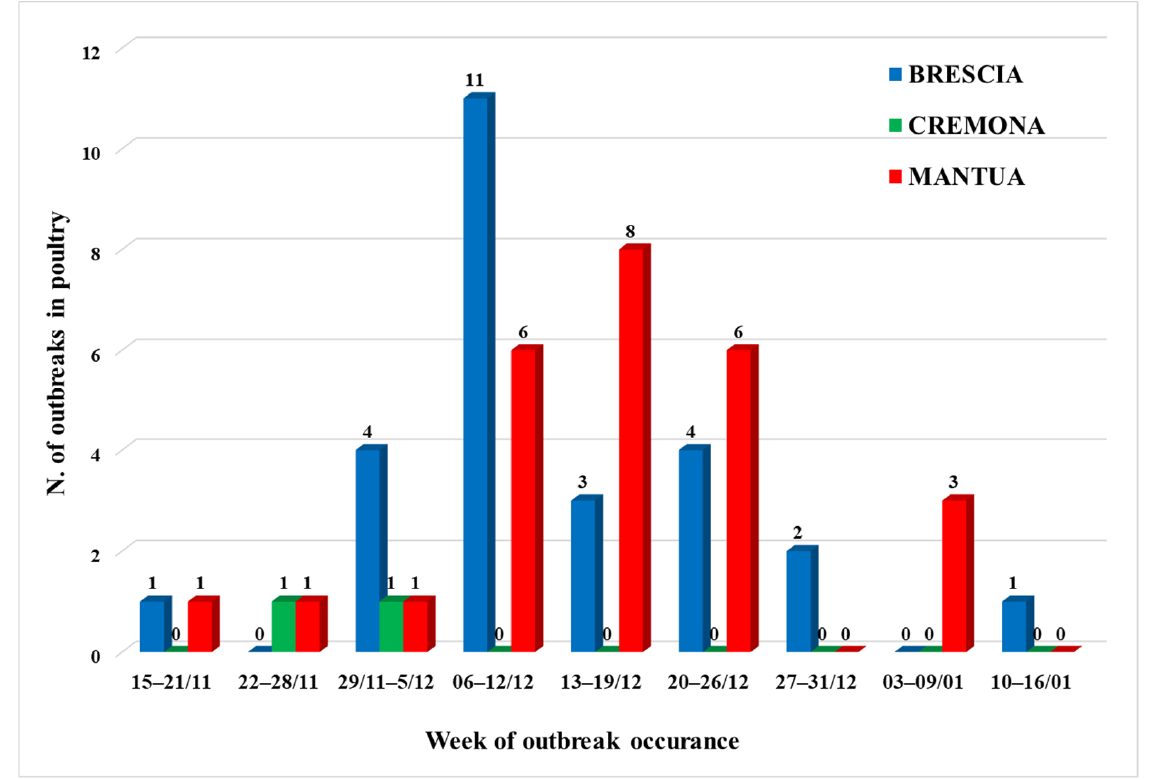
Figure 3. Distribution of outbreaks in industrial farms detected during the HPAI 2021–2022 epidemic in Lombardy, by week and by province.